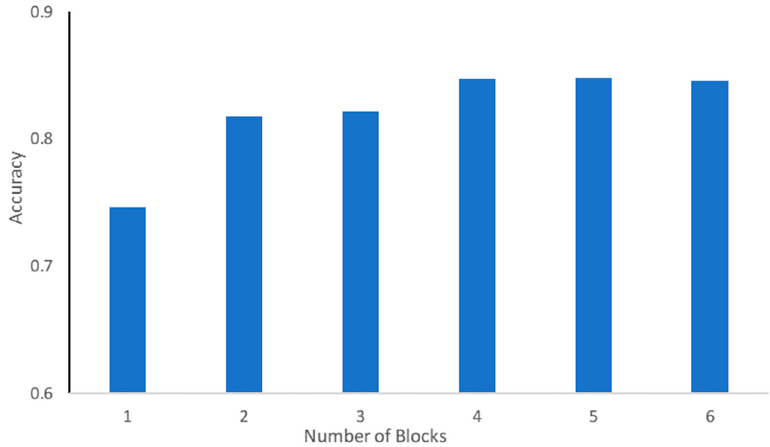
Figure 6. Effect of the number of Inception-Resnet blocks in the proposed DCNN model on classification accuracy.